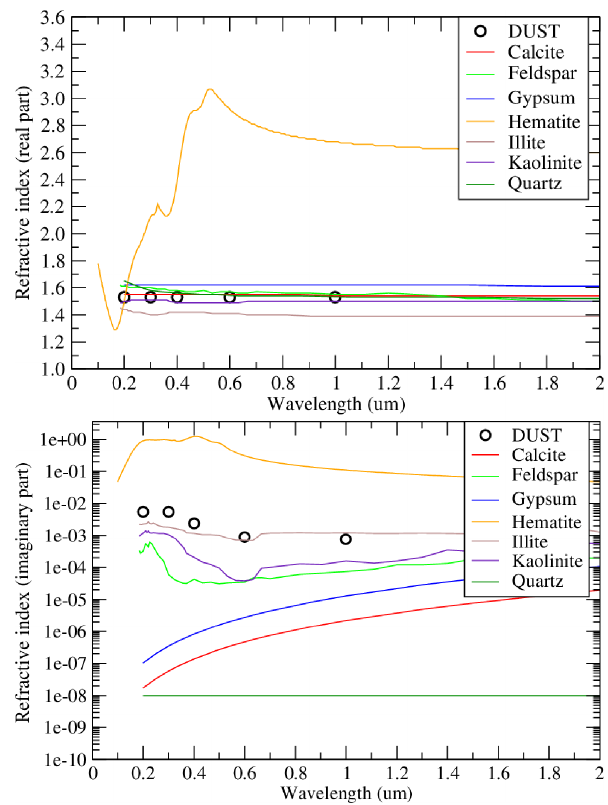
Figure 2. Refractive indices (real and imaginary parts, no unit) for the modelled minerals. DUST corresponds to the model species rep- resenting a mean mineral